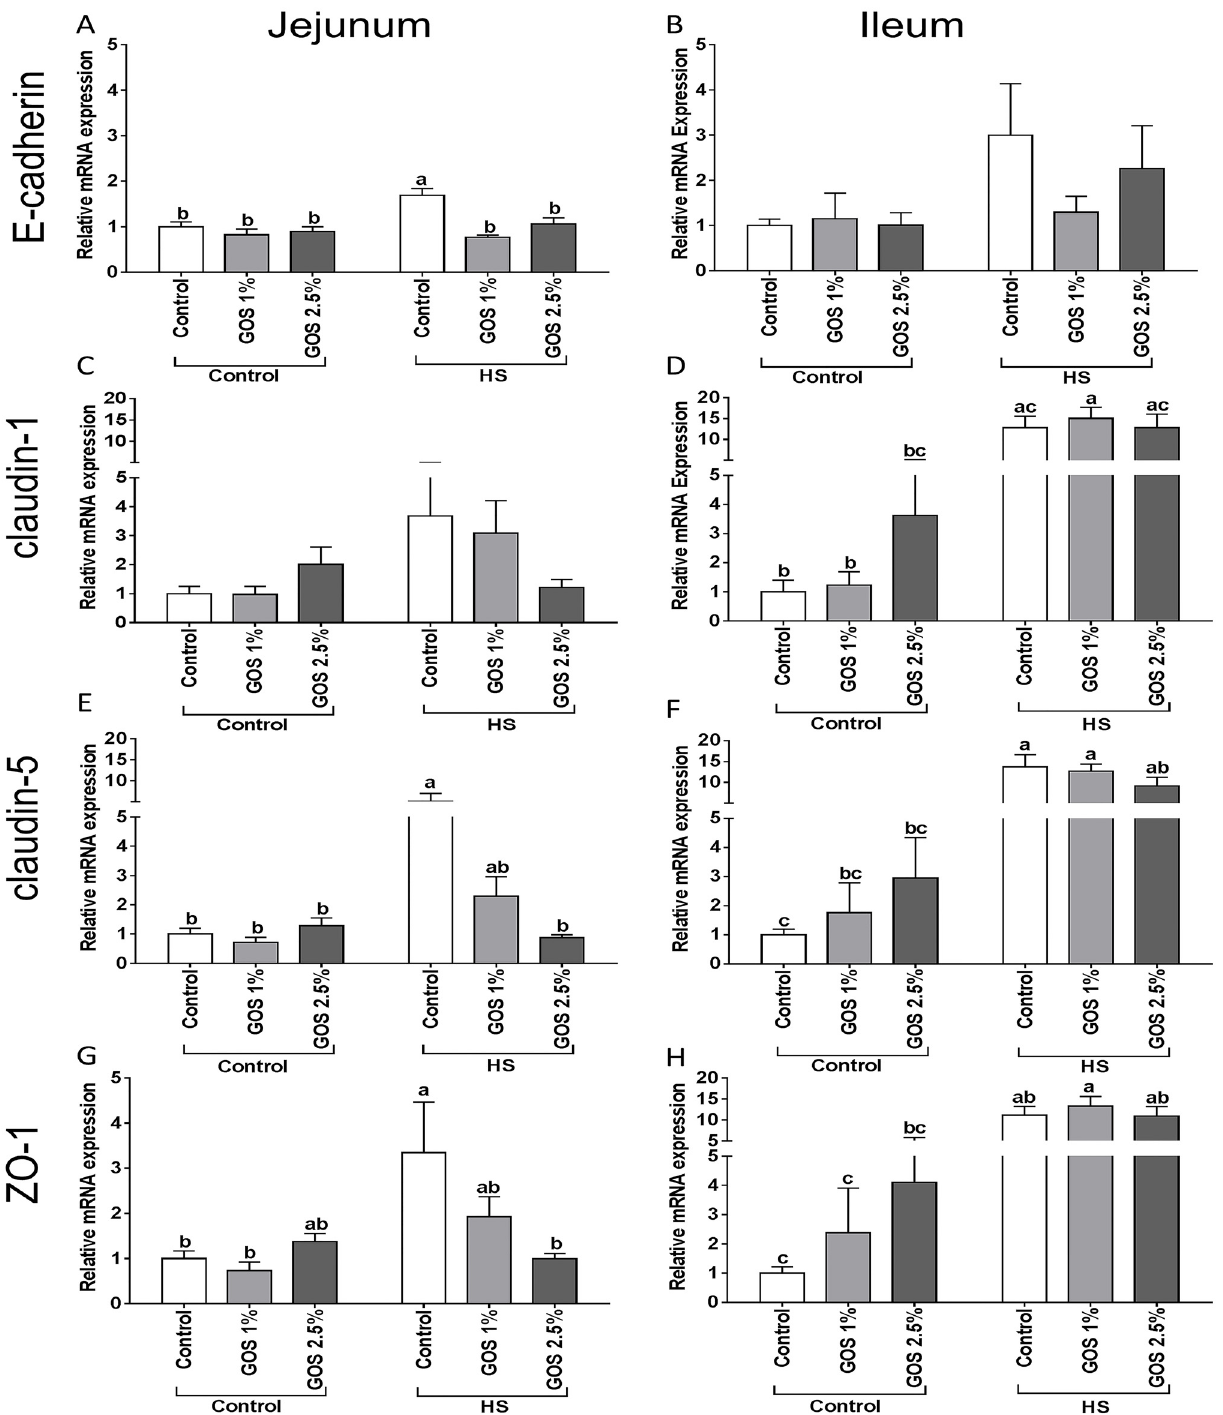
Fig 3. The effect of heat stress exposure on the mRNA expression of AJ and TJ in jejunum and ileum of chickens fed a control or GOS diet. Chickens fed a control or GOS (1 or 2.5%) diet for 6 days before being exposed to either control or heat stress conditions for 5 days. mRNA expression of E- cadherin (A, B), claudin-1 (C, D), claudin-5 (E, F) and ZO-1 (G, H) in jejunum (A, C, E, G) and ileum (B, D, F, H) were evaluated by qRT-PCR. Results are expressed as relative mRNA expression (fold of control, normalized to β -actin) as mean ± SEM, n = 6 – 10 animals/experimental group. Different lower-case letters denote significant differences among